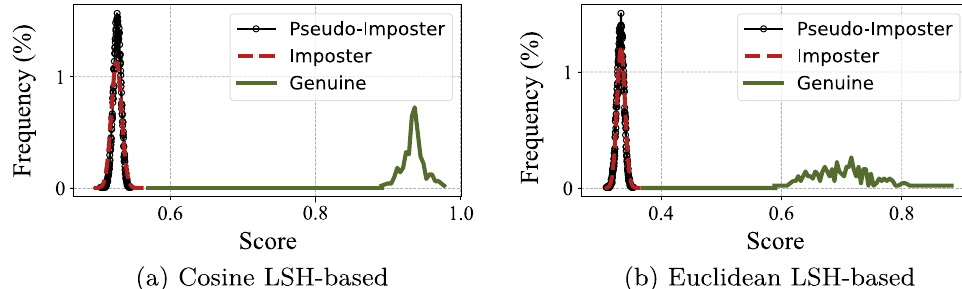
Fig. 14 The pseudo-imposter, imposter and genuine score distributions of CASIA-FaceV5 database with k = 10,000 , d = 2 , N =